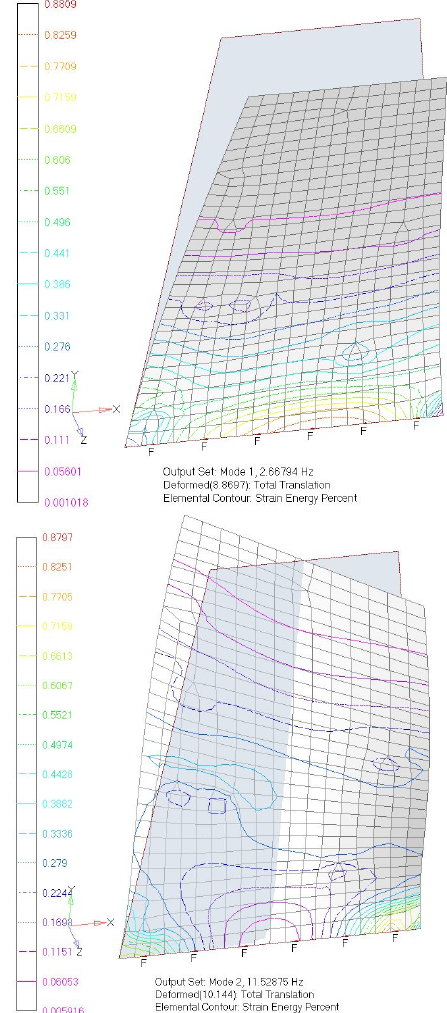
Figure 4. Tapered plate mode shapes